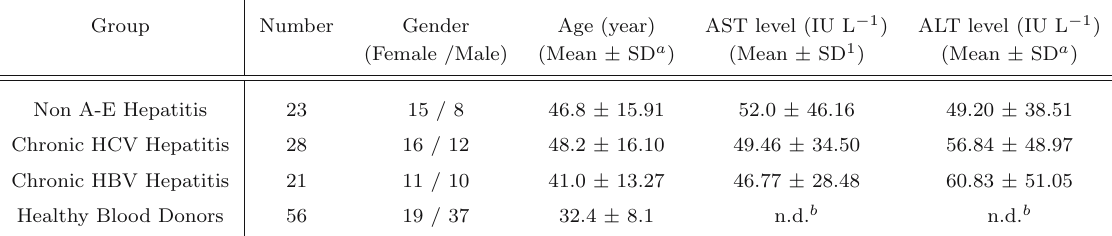
Table 2 Distribution of age, gender, aspartate aminotransferase (AST) and alanine aminotransferase (ALT) levels of the study groups.